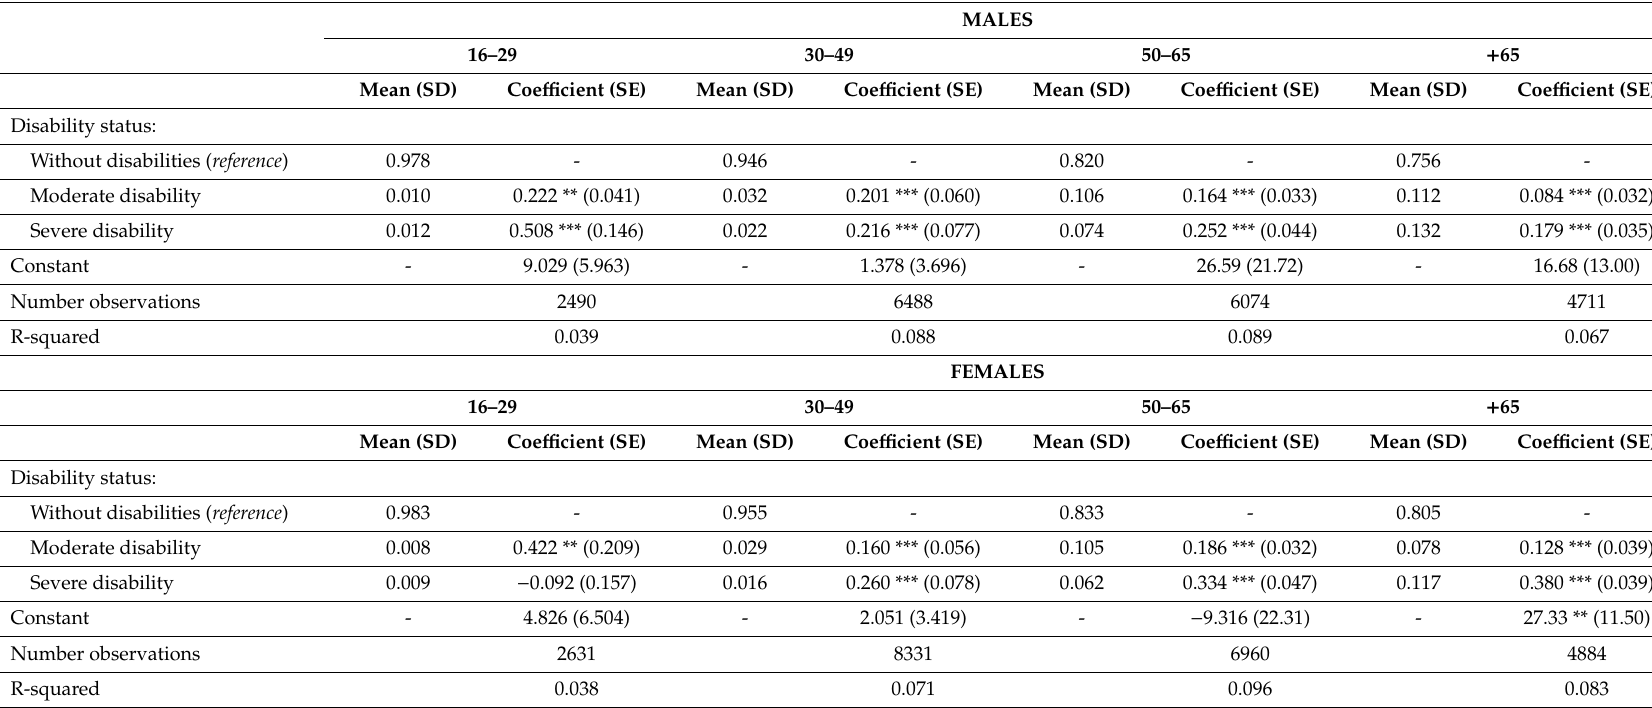
Table 2. Loneliness regression values by di ff erent age groups for German males and